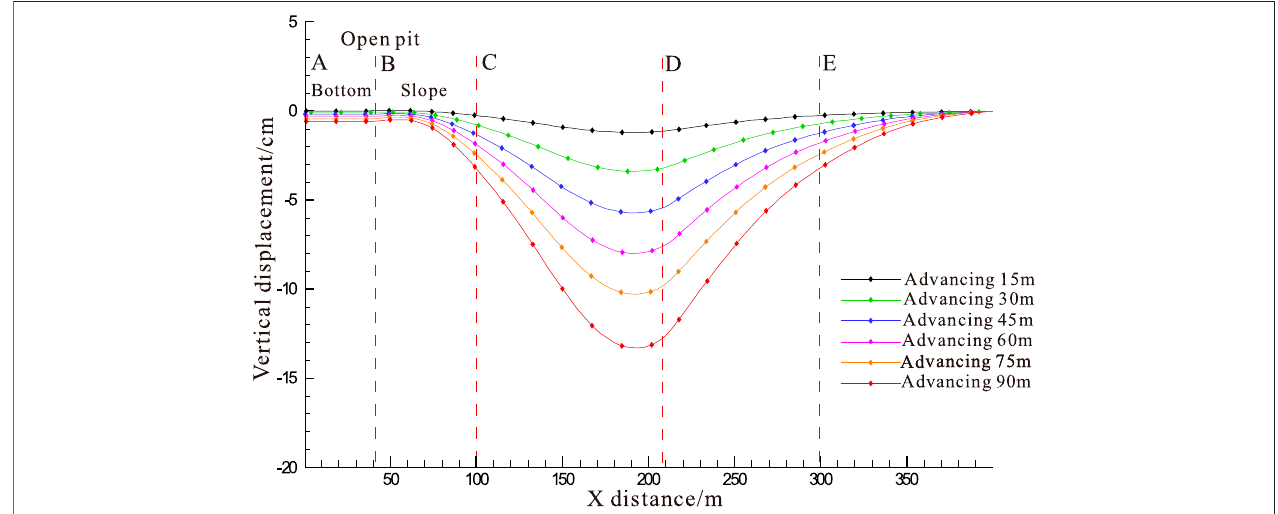
FIGURE 17 | Vertical displacement curves of the surface at different advance distances.